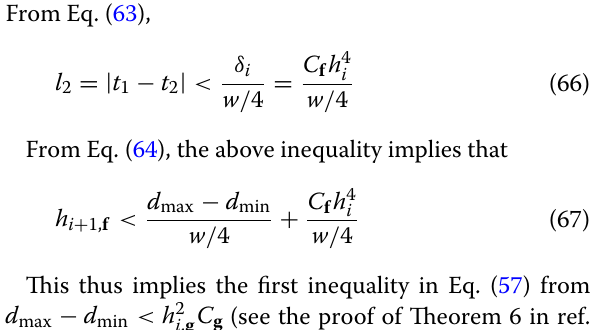
Table 1 Transversal intersections